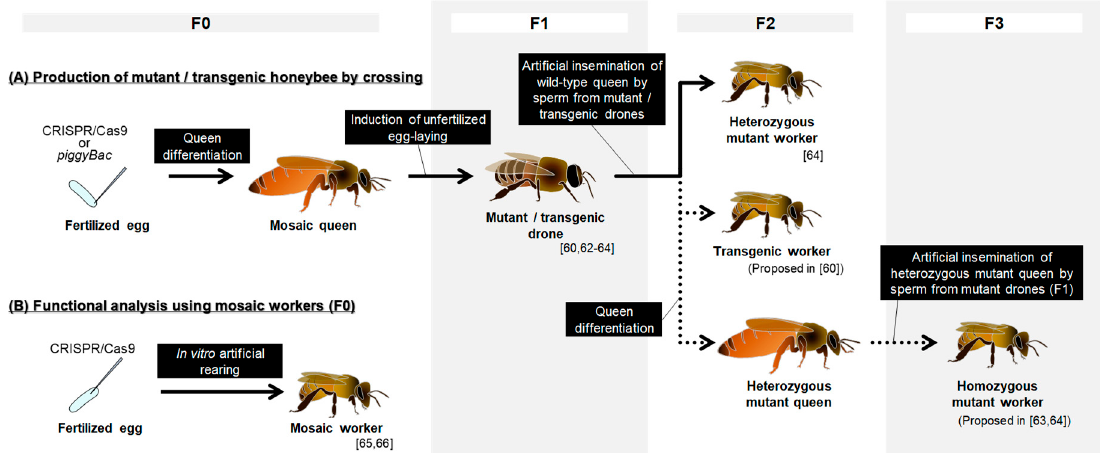
Figure 1. An overview of the procedures to conduct functional analyses utilizing gene modification methods in the honey bee. ( A ) Procedures to produce a mutant/transgenic honey bee by crossing. Arrows with a solid line indicate processes accomplished in previous studies. Arrows with dotted lines indicate the processes proposed in the previous studies, as future studies. ( B ) The alternative methods for analyzing gene functions using mosaic workers (F0) artificially reared from injected eggs.